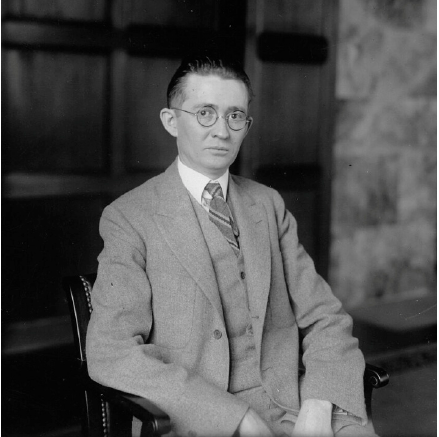
Figure 1. Lemuel Roscoe Cleveland (1892–1969). Smithsonian Institution Archives, Image #SIA2008-0153. The Smithsonian has granted permission for use.